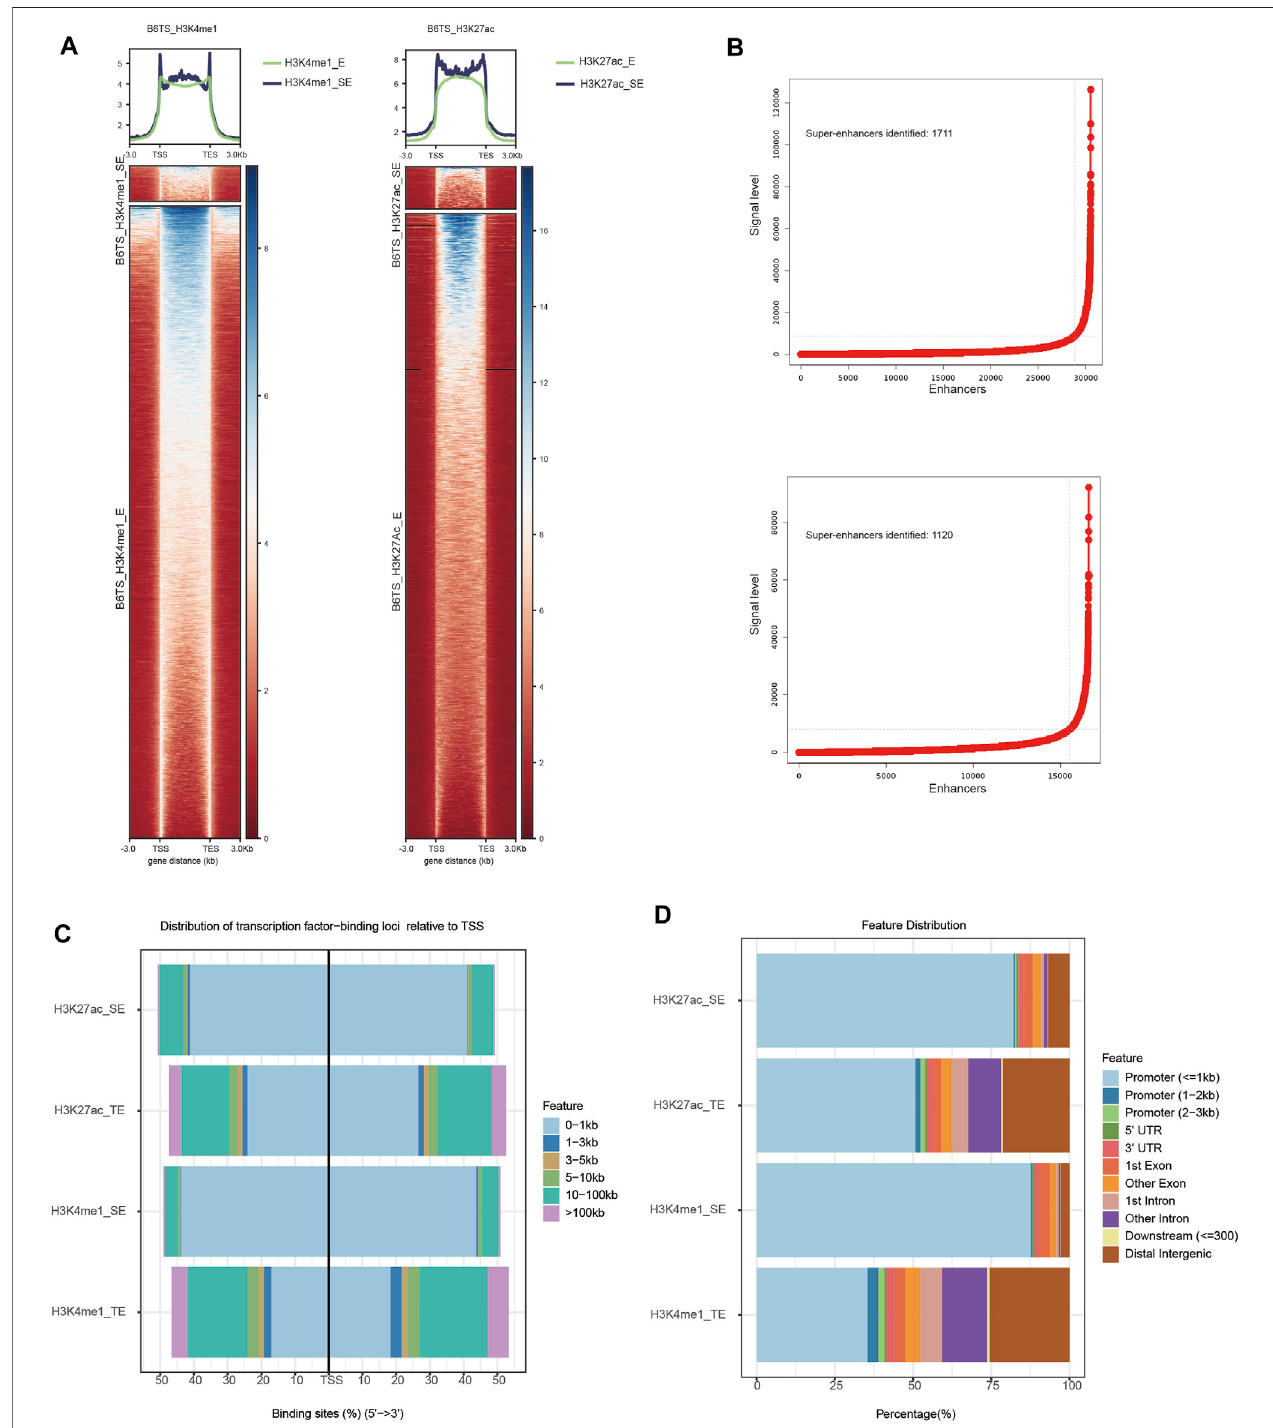
FIGURE 1 | Pro fi les of SEs in TSCs (B6TS). (A) Heatmaps showing the average signal levels of H3K27ac and H3K4me1 SEs and TEs in TSCs (B6TS). (B) Identi fi cationofSEs.Enhancerswithin12.5 kbwerestitchedtogetherandrankedbytheleveloftheH3K27acandH3K4me1signals.EnhancerswithanH3K27acsignal aboveacutoffofaslopeof1onthecurvewereconsideredSEs. (C) DistributionofSEsandTEsthroughoutthegenome(transcriptionfactor-bindinglocirelativetoTSS). (D) Distribution of SEs and TEs throughout the genome (distribution features).